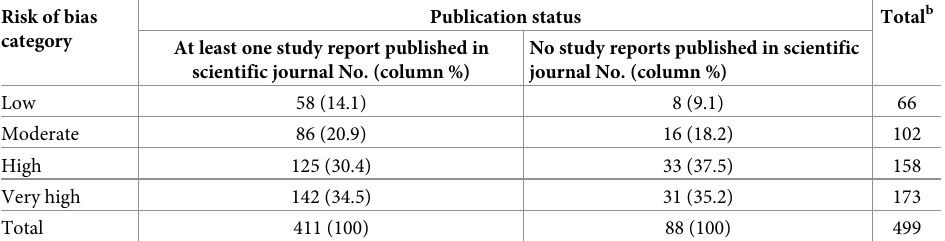
Table 3. Number of studies stratified by publication status and risk of bias category a